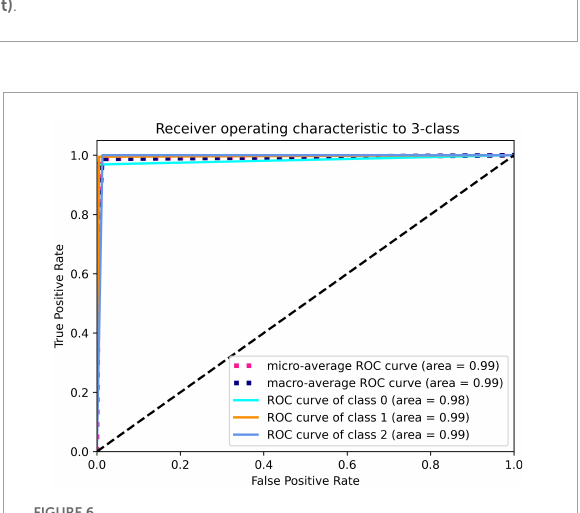
FIGURE6 Deep learning framework detection of cholesteatoma (class 0), LCH (class 1), and MEI (class 2).